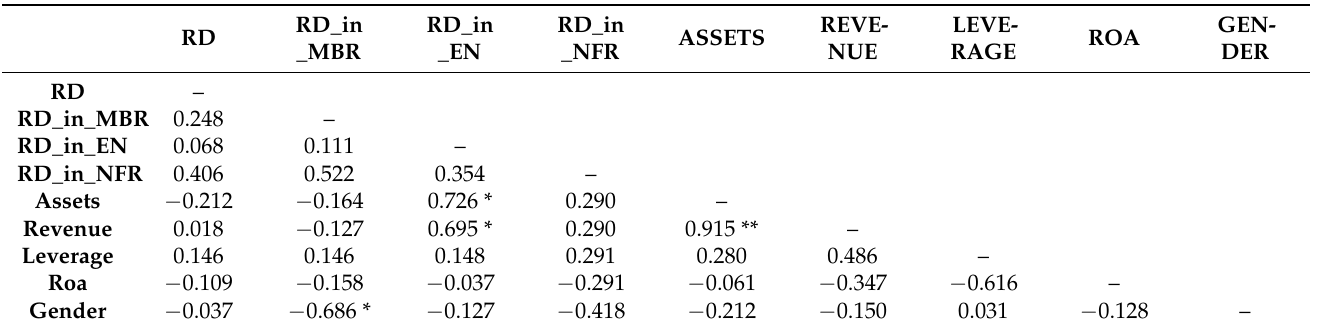
Table 5. Correlation Matrix.